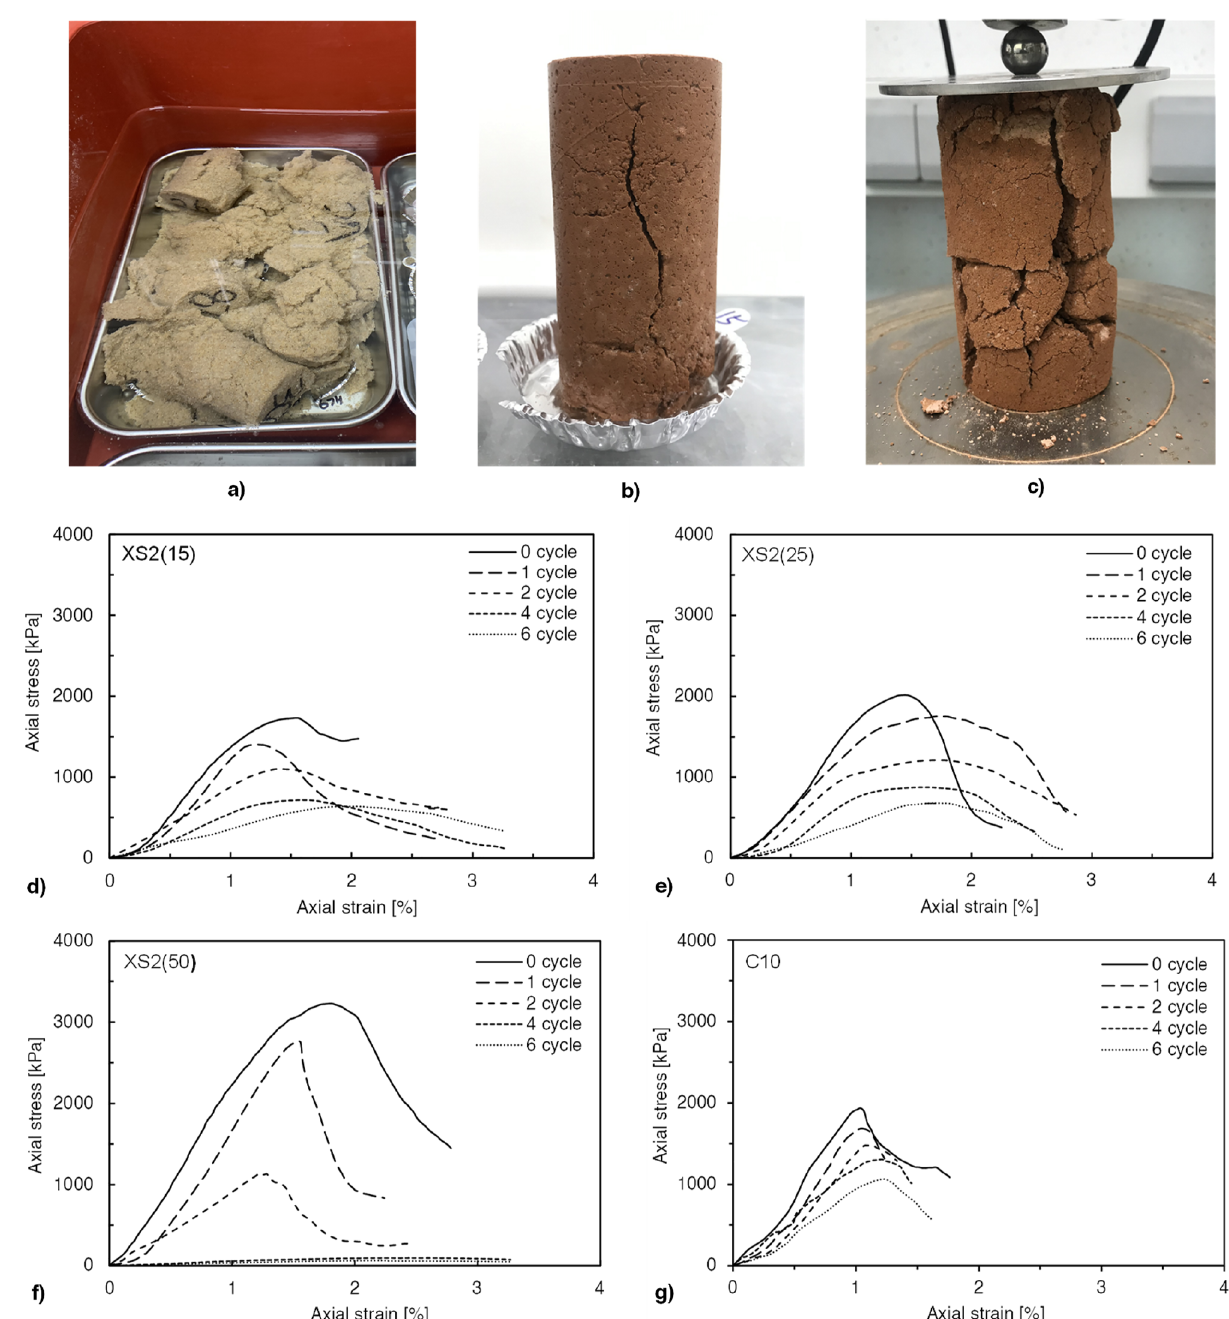
Figure 7. Response to exposure under W–D cycles. ( a ) The collapse of XS2 samples at the first wetting. ( b ) Crack development in XS2(50) after the second W–D cycle. ( c ) XS2(50) splitting into fragments after repetitive swelling and shrinkage (after the sixth cycle). Stress–strain curves after cyclic W–D (1–6 cycles) of ( d ) XS2(15), ( e ) XS2(25), ( f ) XS2(50), and ( g ) XS2(25) mainly occurred during the first cycle and became constant after the first cycle (Fig. 8b). In contrast, the E 50 value of XS2(50) showed a continuous decrease with W–D cycles, showing a tendency similar to the q u results. As previously shown in Fig. 7b,c, a rapid q u deterioration of XS2(50) was observed due to cracks developed on the surface of the samples despite their high initial strength. During the drying process, cracks are generated on the surface of XS2(50) owing to the extreme shrinkage and swelling caused by moisture loss and absorption. The XG biopolymer has a natural affinity toward the water, originating from the anionic side chains in its molecular structure 30 . Thus, biopolymer-treated soils, especially those that include fines, would attract and retain more moisture within the soil matrix through synergetic effects with clay activity 44 . This characteristic was expected to contribute to more shrinkage, especially in XS2(50), with more fines content. Once a crack occurs on the